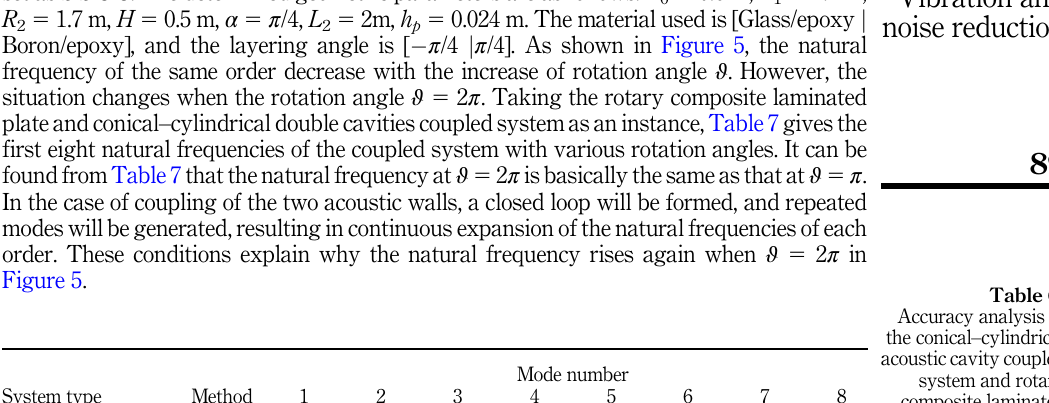
Figure 5. The variation curve of